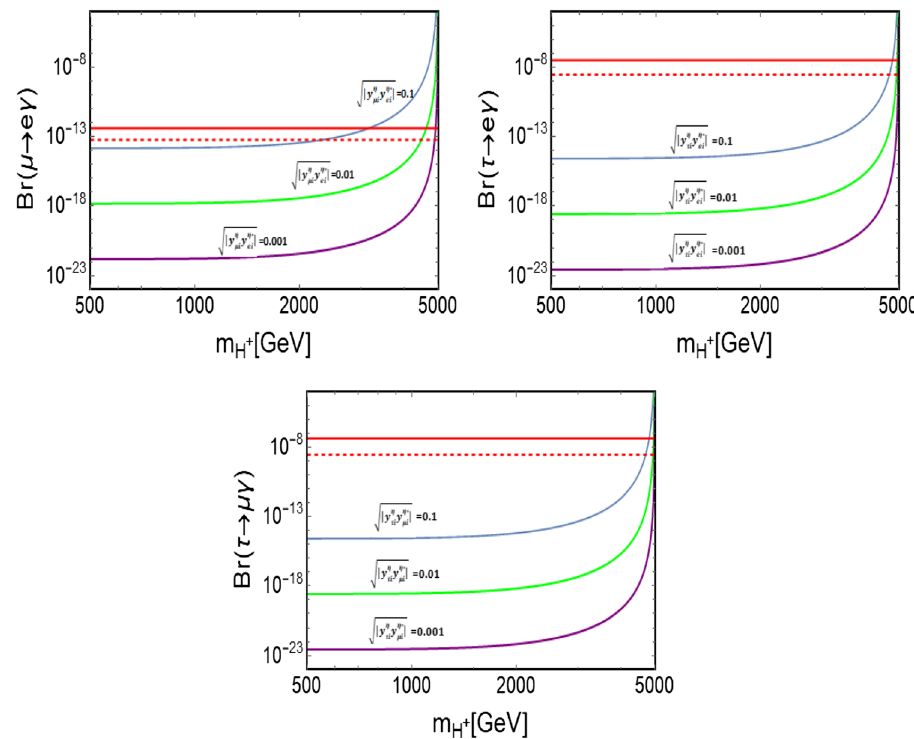
Fig. 7 Branching ratio predictions for the processes: μ → e + γ (top left), τ → e + γ (top right) and τ → μ + γ (bottom) as a function of mass ( m H + ) in scotogenic one-loop Dirac neutrino mass model for three benchmark values of Yukawas: (cid:28)(cid:21) (cid:21)